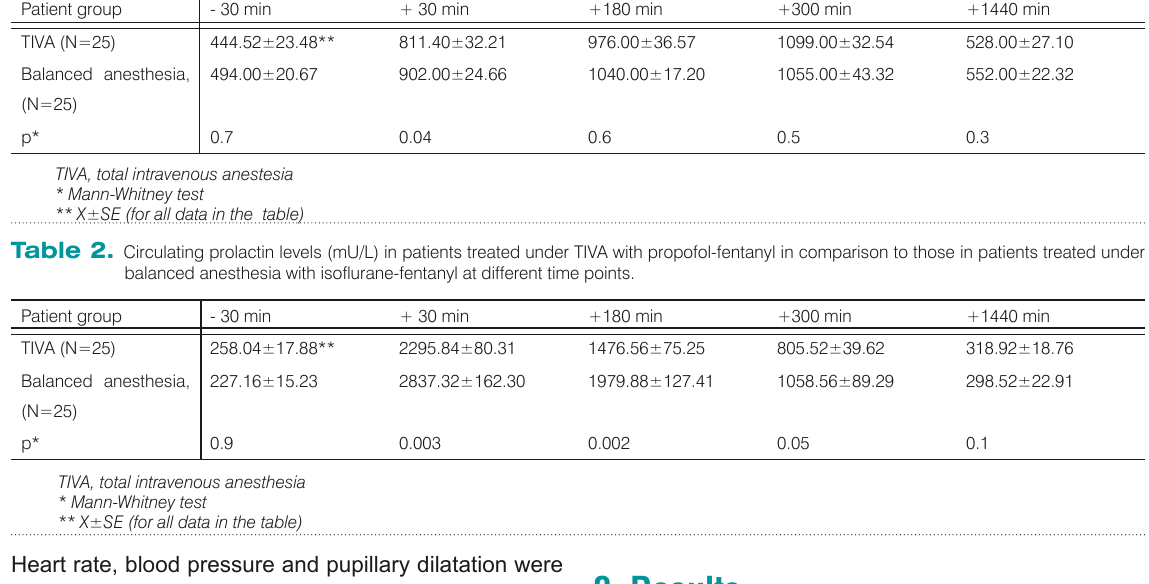
Table 1. Circulating cortisol levels (nmol/L) in patients treated under TIVA with propofol-fentanyl in comparison to those in patients treated under balanced anesthesia with isoflurane-fentanyl at different time points.